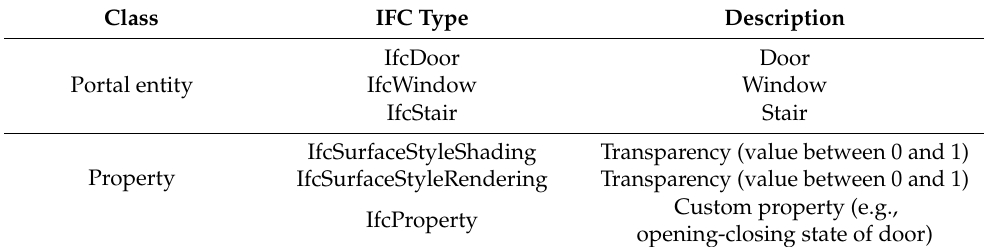
Table 1. Definition of “visibility”.